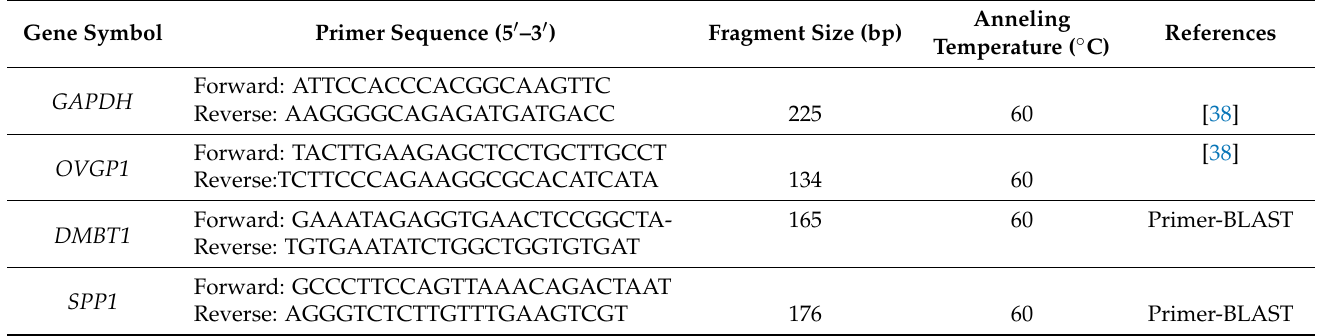
Table 1. Primer sequences and corresponding annealing temperatures for RT-qPCR